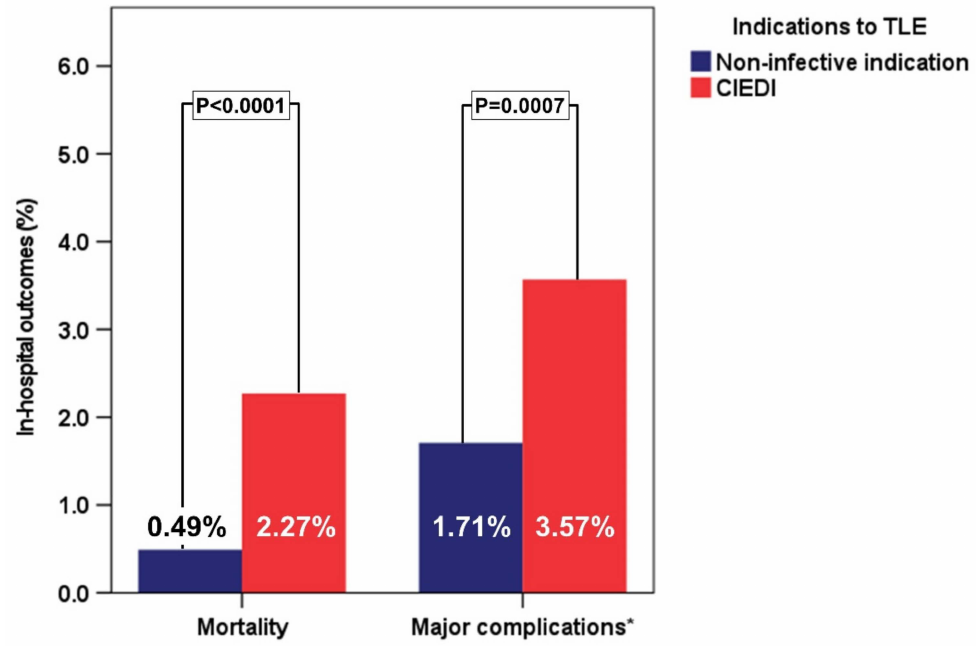
Figure 1. In-hospital clinical outcomes in patients undergoing TLE according to the presence/absence of CIEDI. Legend: CIEDI = CIED infection; TLE = transvenous lead extraction. * = including